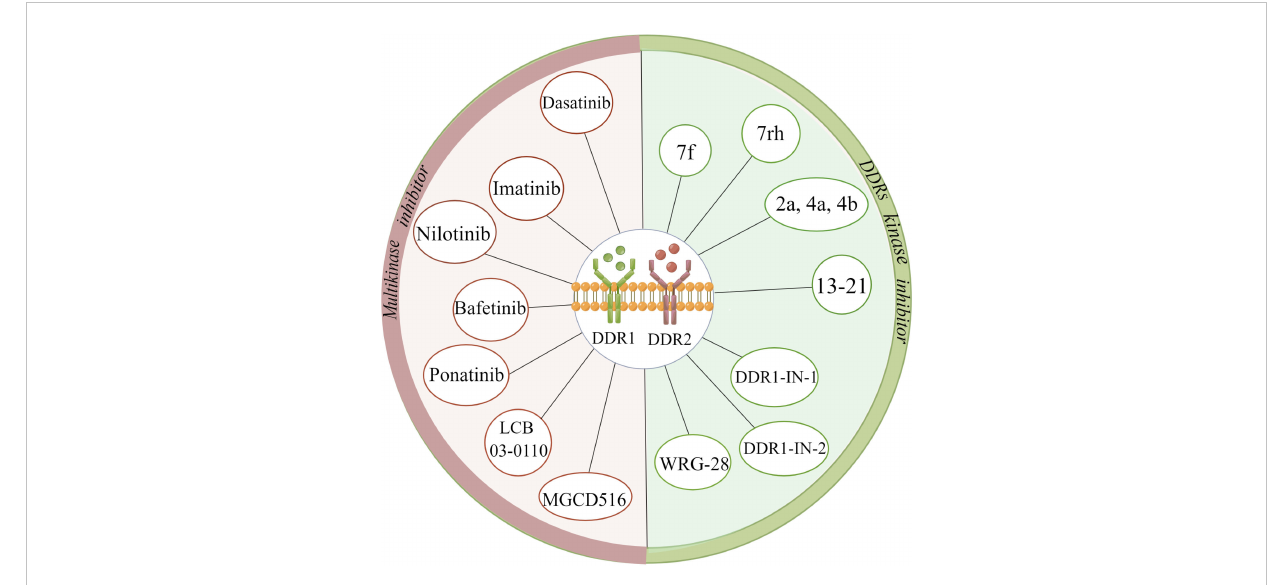
FIGURE 4 Summary of various discoidin domain receptors inhibitors. (The fi gure is drawn by